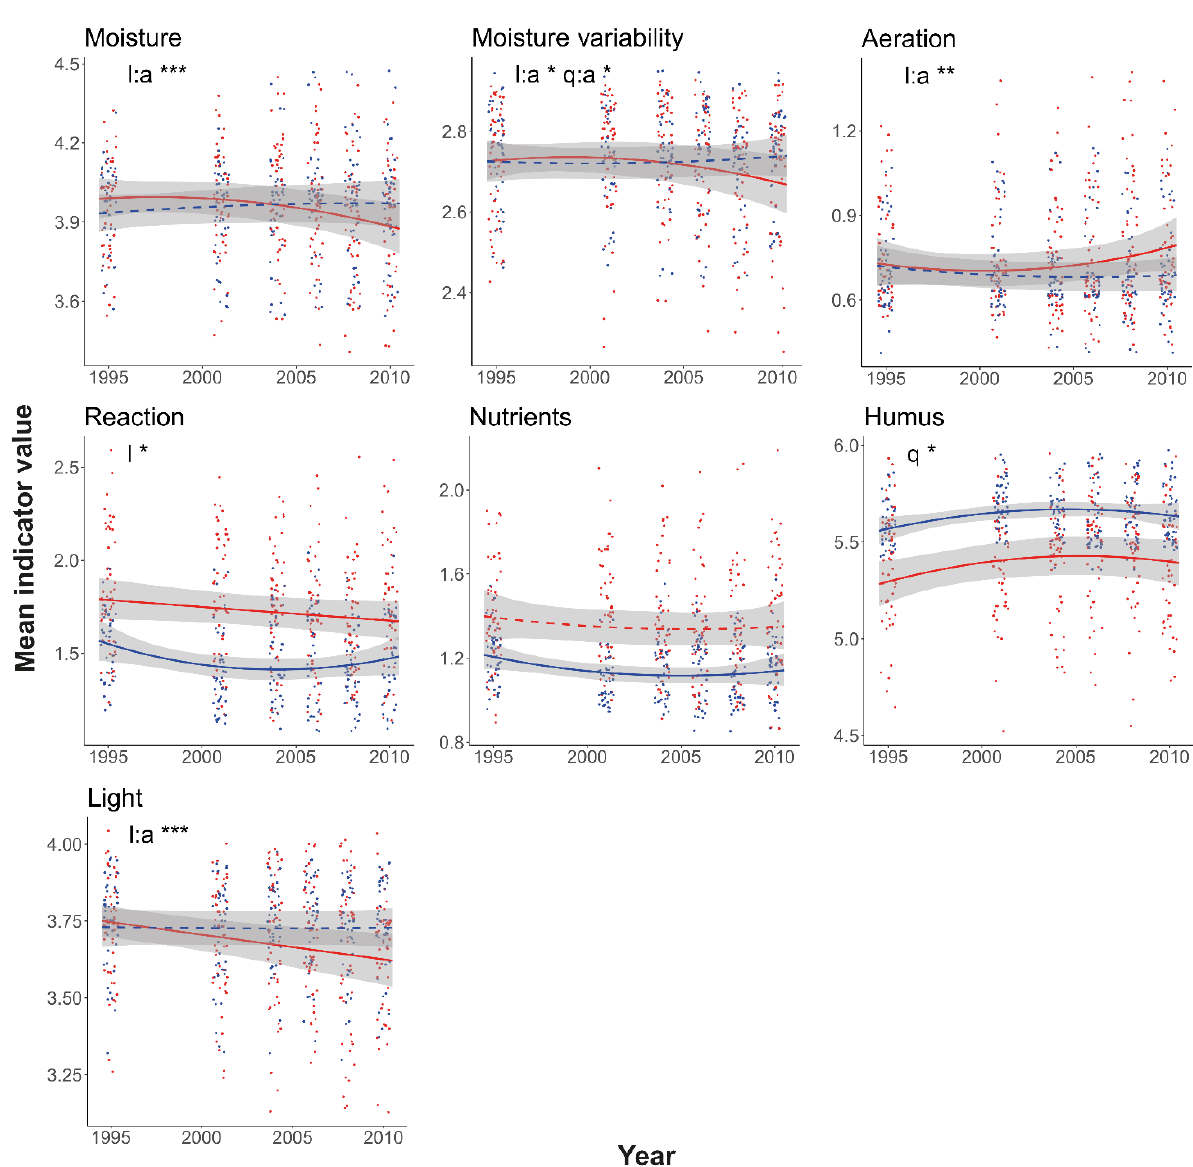
both of these variables in poor fens (Tables 3,